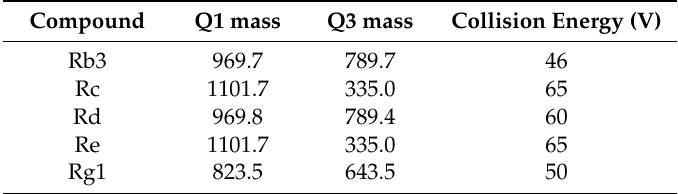
Table 3. Mass spectrometry parameters for the detection of